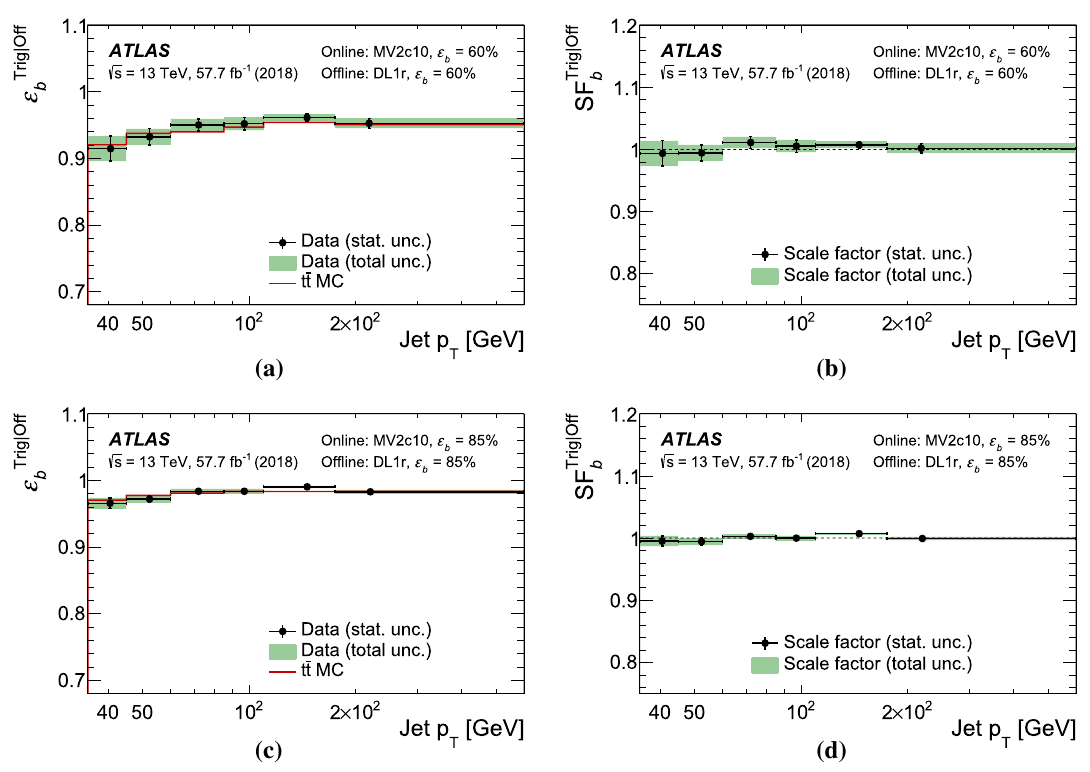
| Off Fig. 14 The conditional b -tagging efficiency, ε Trig to pass the same efficiency working points as the online jets, but using , ( a , c ) and cor- b | Off the DL1r b -tagging algorithm. Vertical error bars include data statisti- , ( b , d ) for the online MV2c10 algo- responding scale factor, SF Trig b cal uncertainties only, whereas the full band corresponds to the sum in rithmforthe60%efficiencyworkingpoint( a , b )andthe85%efficiency quadrature of all working point ( c , d ) as measured in 2018 data. Offline jets are required